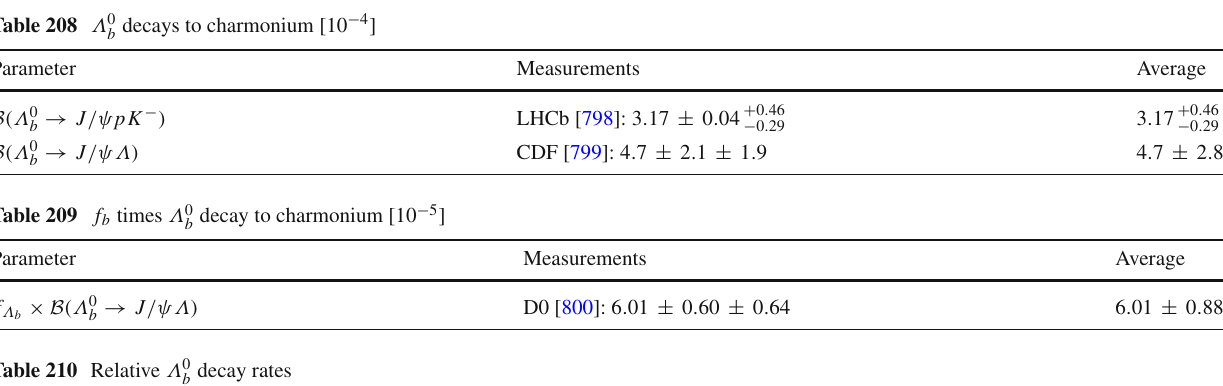
Table 210 Relative Λ 0